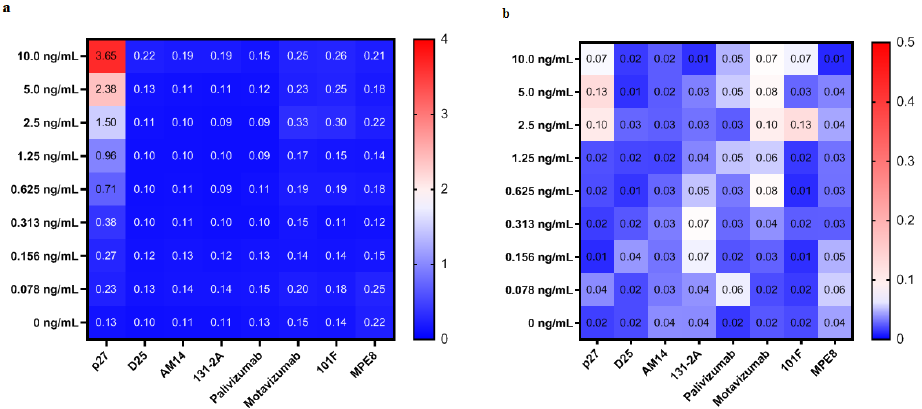
Figure 1. Sensitivity and specificity of ELISA for p27 antibody detection. ( a ) The heat map shows the average optical density (OD) values of p27 monoclonal antibody (p27 mAb) from 3 independent ELISAs when different concentrations of p27 peptide, p27 mAb as well as alternative mAbs were used in the assay. Red and blue indicate strong and weak binding of p27 peptide coated on the plates and the corresponding mAb on the bottom of the figure, respectively. ( b ) The heat map shows the SEs (standard error of the mean) of OD values of p27 mAb from 3 independent ELISAs when different concentrations of p27 peptide, p27 mAb as well as alternative mAbs were used in the assay. Red and blue indicate high and low of SEs calculated, respectively. The heat map was made by GraphPad Prism version 8.3.0 for Windows, GraphPad Software, La Jolla California USA.